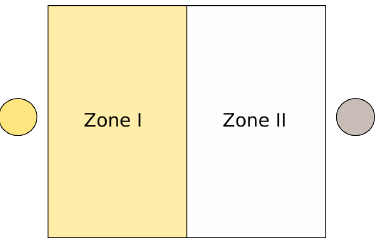
Figure 1: Division of the arena into two zones: left, zone I, bright light; right, zone II, dimmed or no